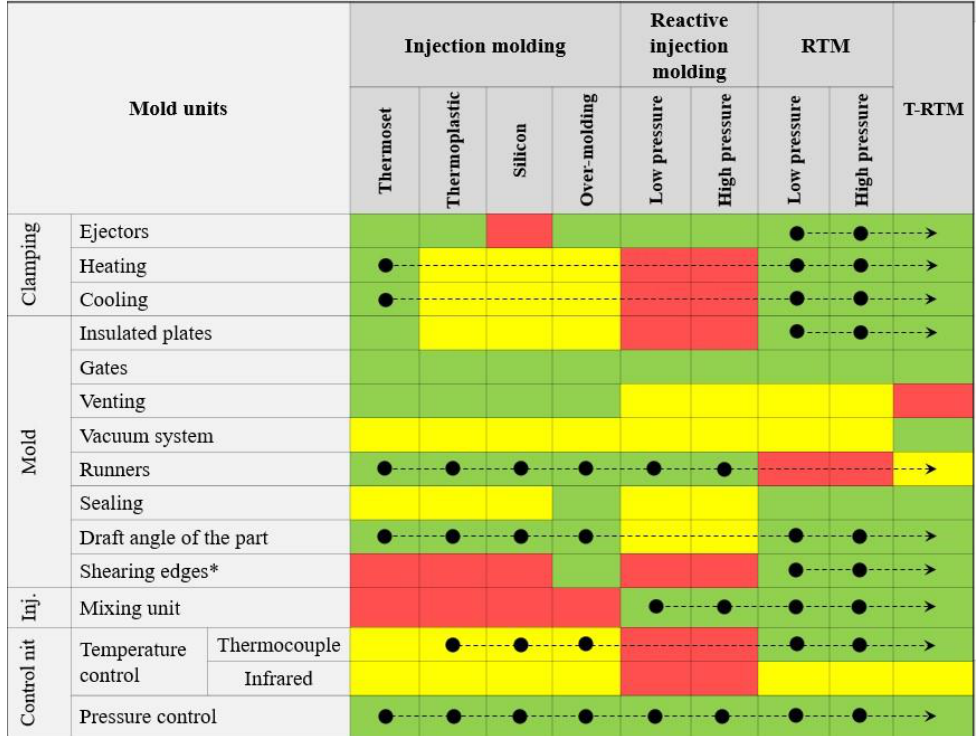
Figure 3. A decision-making map for T-RTM mold design (green color—a relevant unit for this type of mold; yellow color—partially relevant unit; red color—not relevant unit; black dot—the closest analogues of each unit in different molds to those of the T-RTM mold) (based on ref. [14–17]).